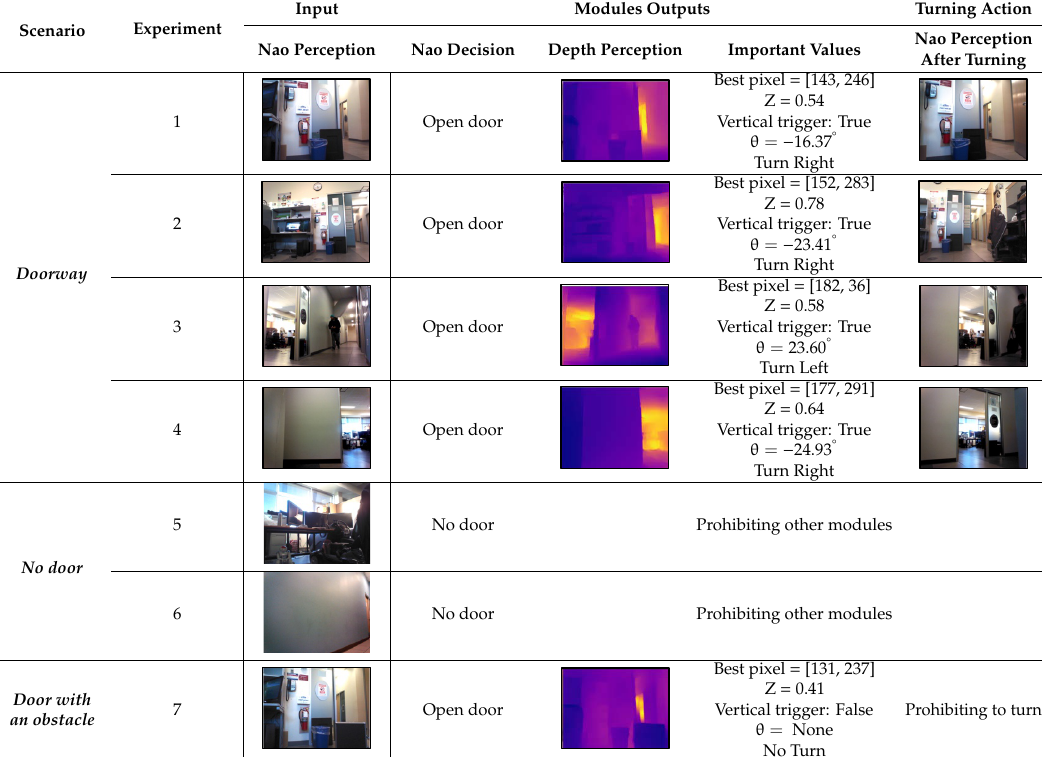
Table 5. Qualitative comparison of related algorithms.